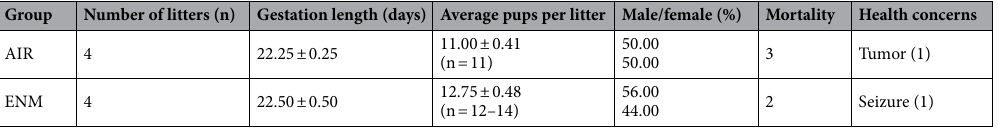
Table 1. Litter characteristics. Values are shown as mean ± SEM. Statistics were analyzed with a students T-test ( p <